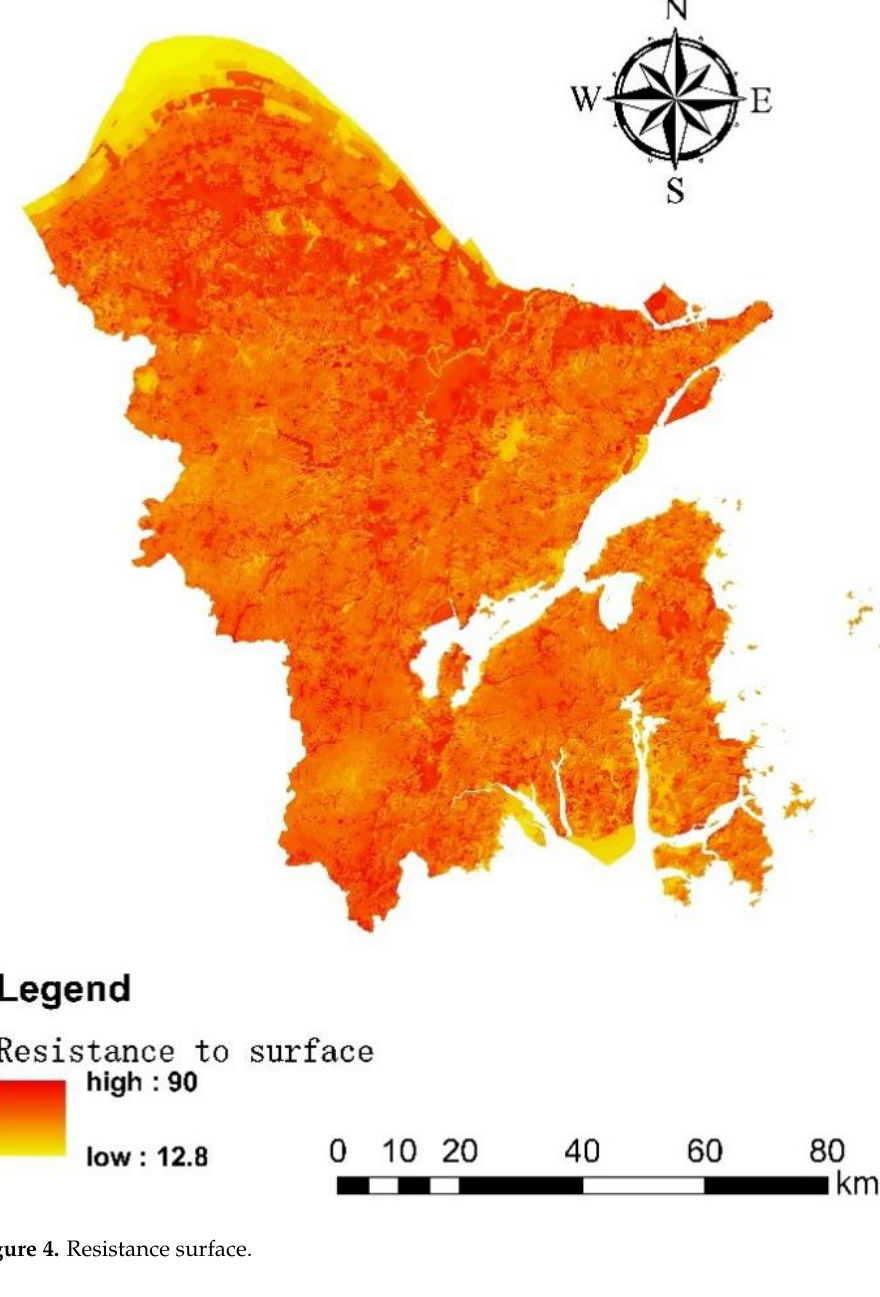
Figure 4. Resistance Fig. 4. Resistance surface.